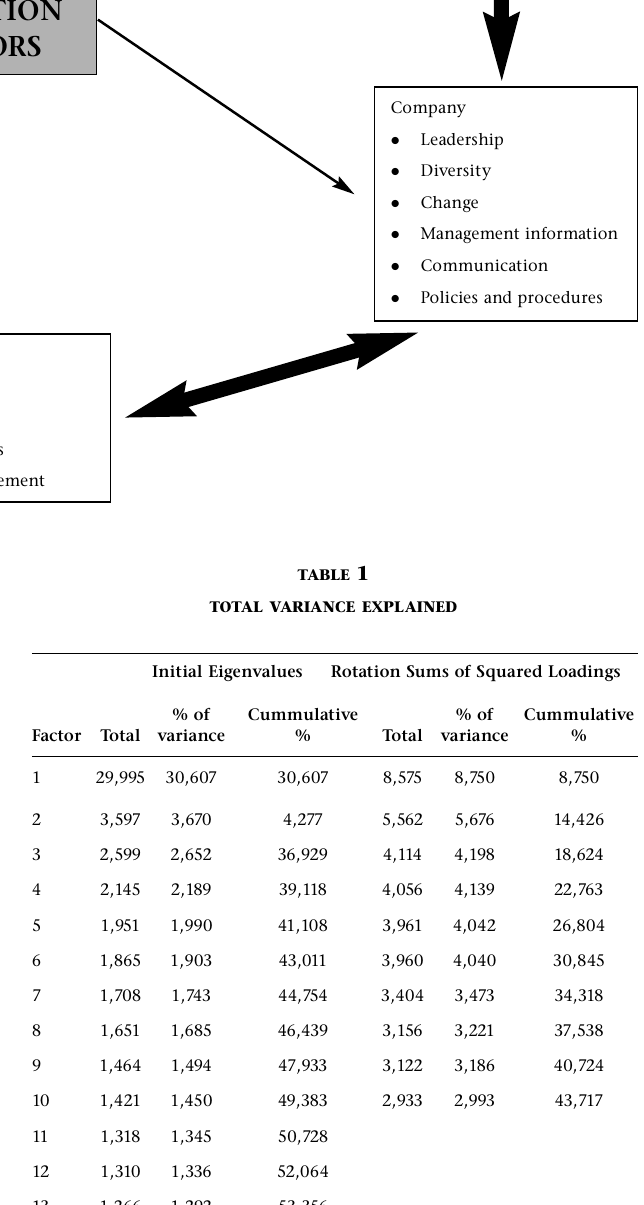
Non-Financial Rewards and